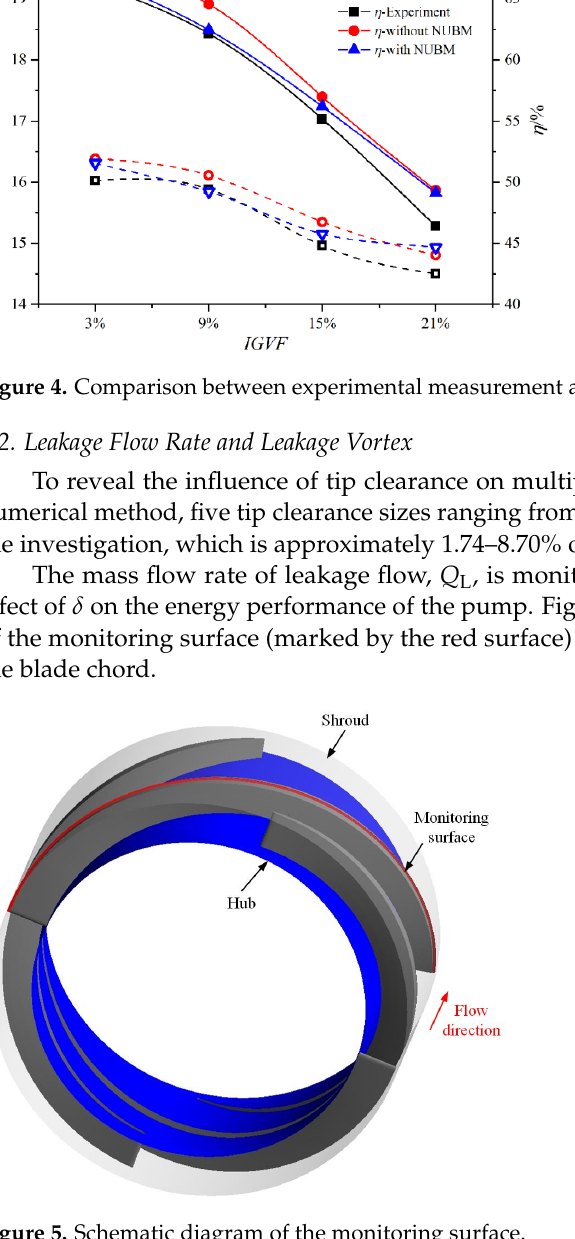
Figure 3. Test bench for the multiphase pump: ( a ) Multiphase rotodynamic pump; ( b ) High-speed camera; ( c ) Pressure transducer; ( d ) Electromagnetic flowmeter; ( e ) Turbine flowmeter; ( f ) Buffer tank.